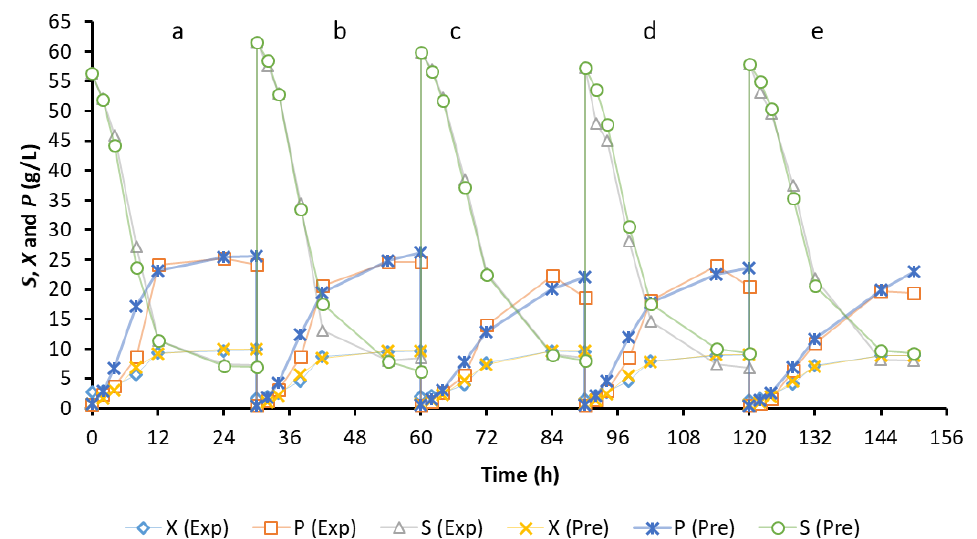
Figure 3. Cell growth, ethanol production and substrate consumption curves fitted by the logistic model, LP model and MLP model.